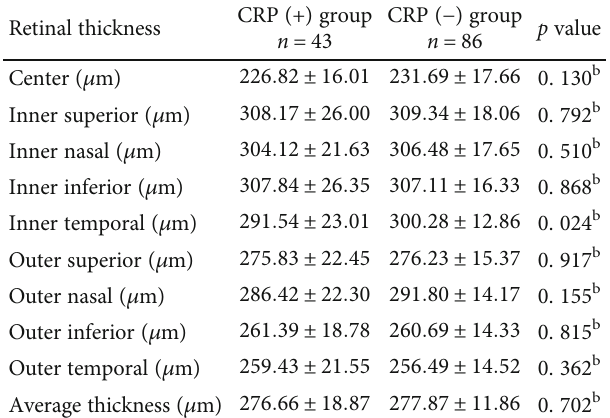
Table 2: The retinal thickness of nine sectors of the ETDRS grid.